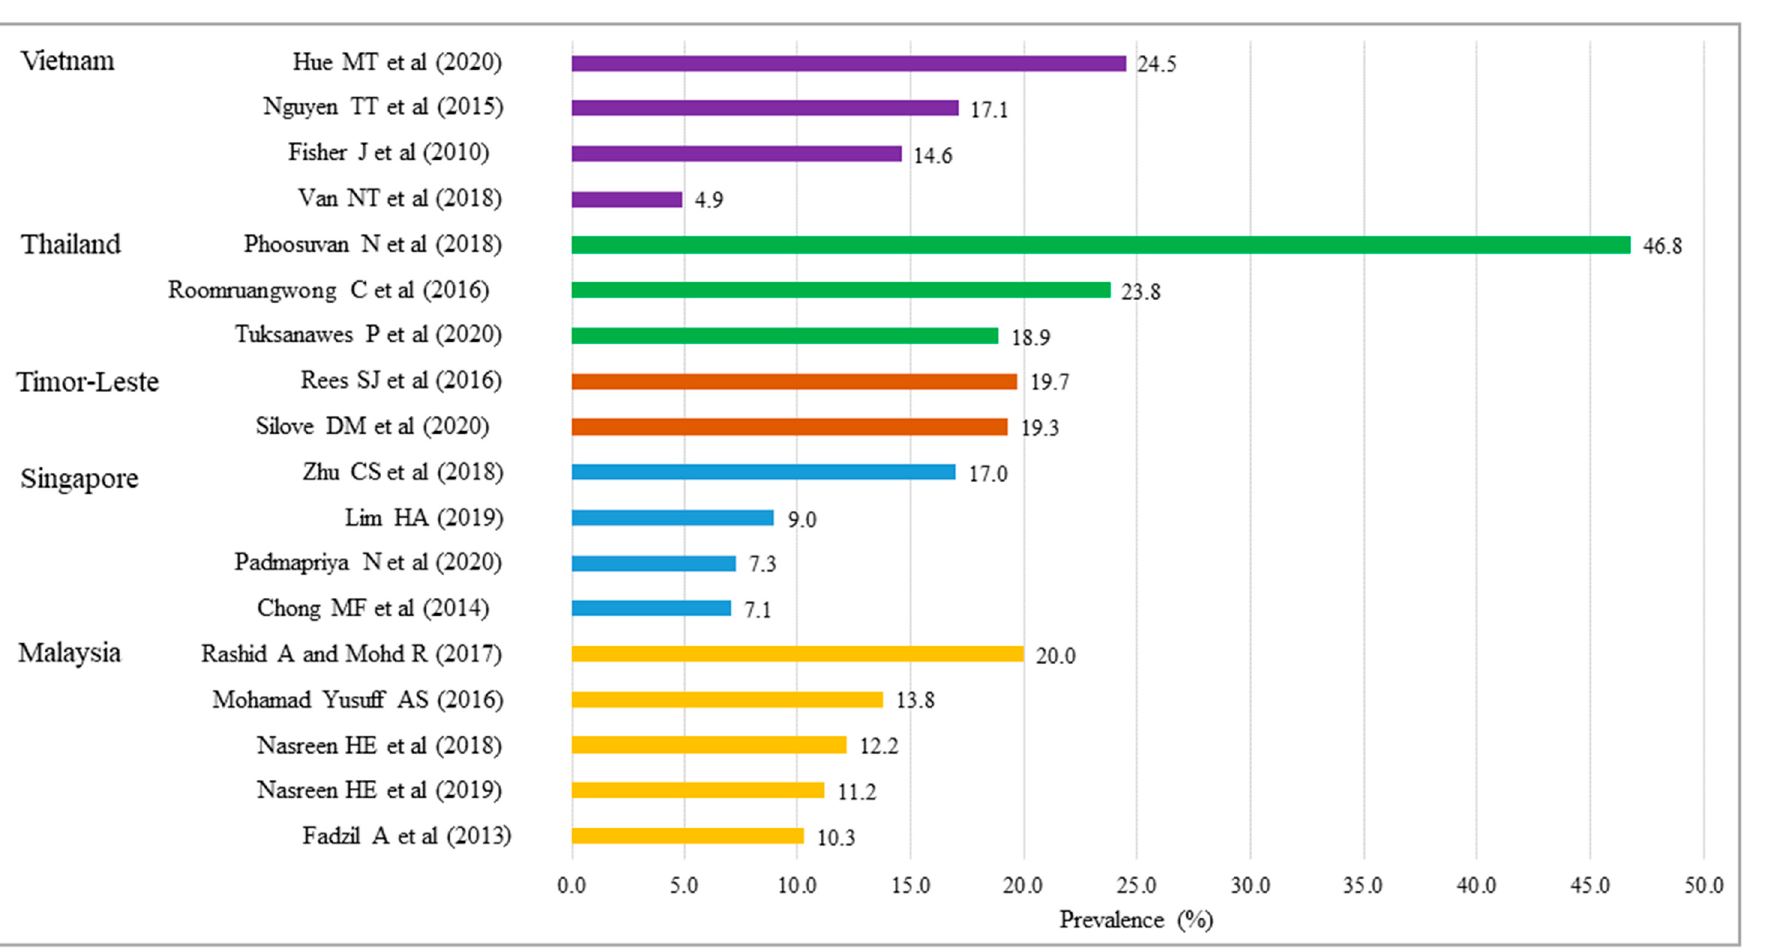
Figure 2. Prevalence of antenatal depression in the ASEAN member countries [21–38].